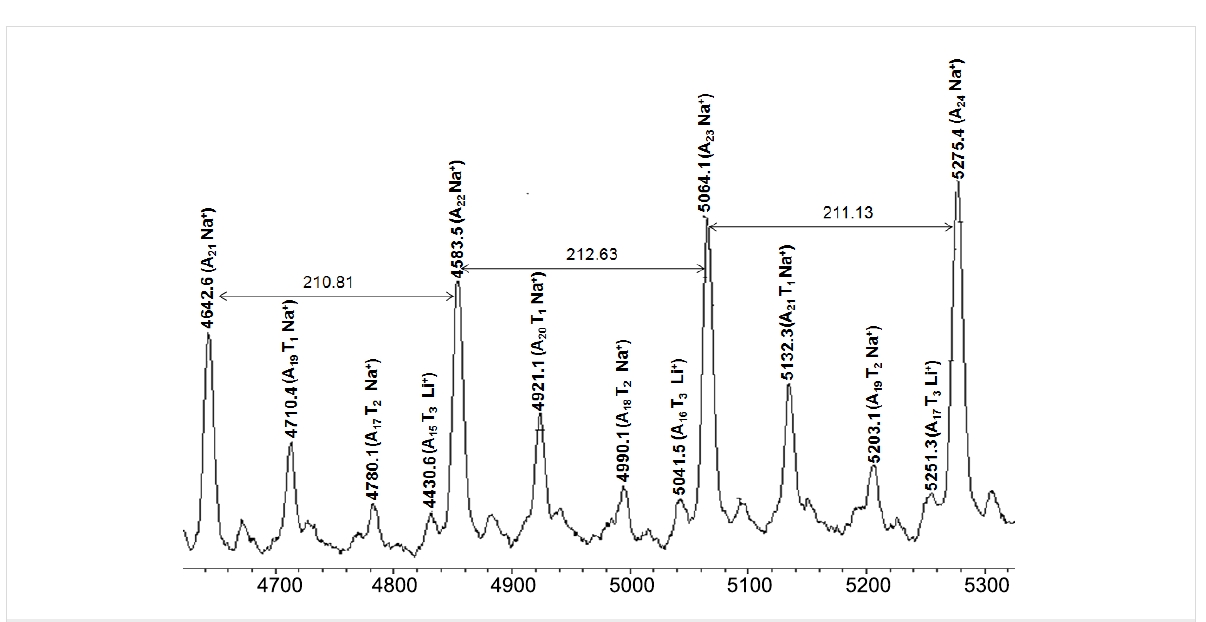
Figure 9: MALDI-TOF mass spectrum of BCP-A 25 T 1 synthesized with catalyst U3 .